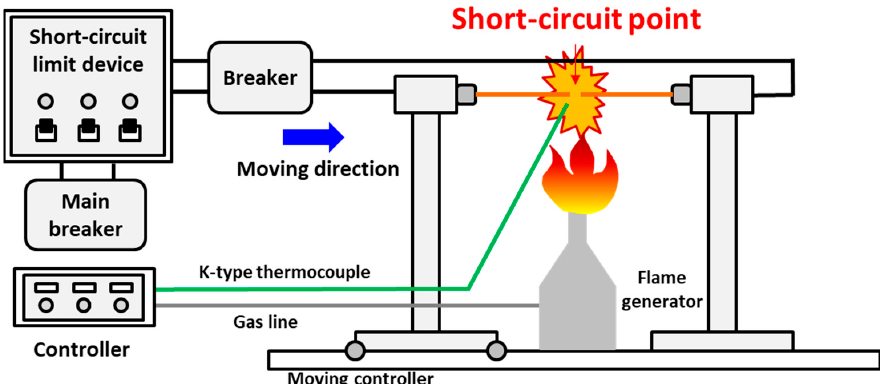
Figure 1. Schematic illustration of the short-circuit generator.